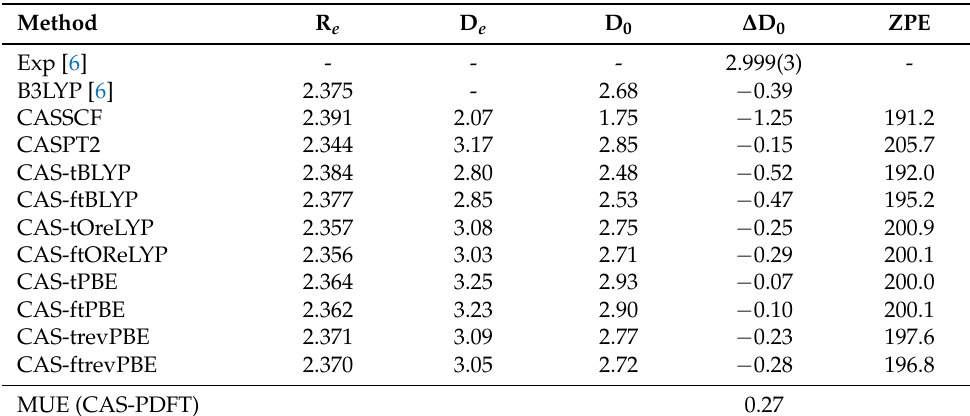
Table 10. Dissociation energies (eV), equilibrium bond lengths (Å), and zero point energies (in cm − 1 ) for TaSi in the 4 Π molecular state, computed with a CASSCF wave